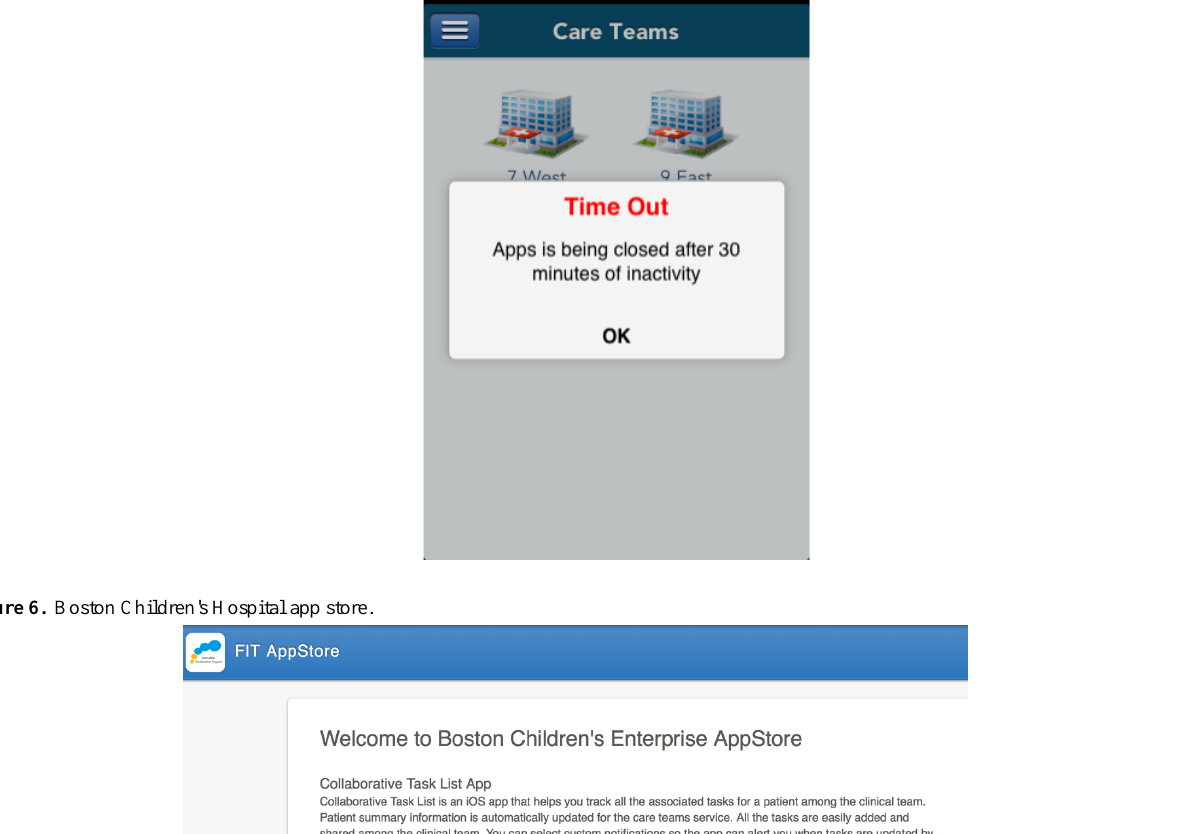
Figure 5. TaskList will be closed after 30-minute of inactivity.